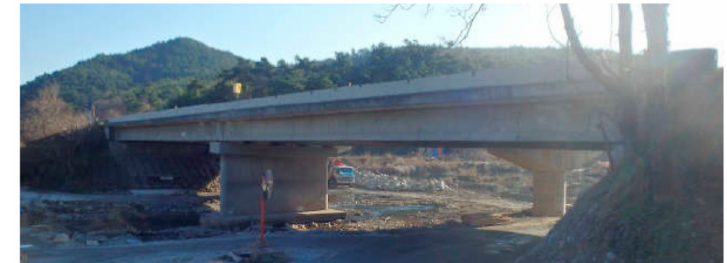
Figure 1. Front view of the deteriorated bridge.